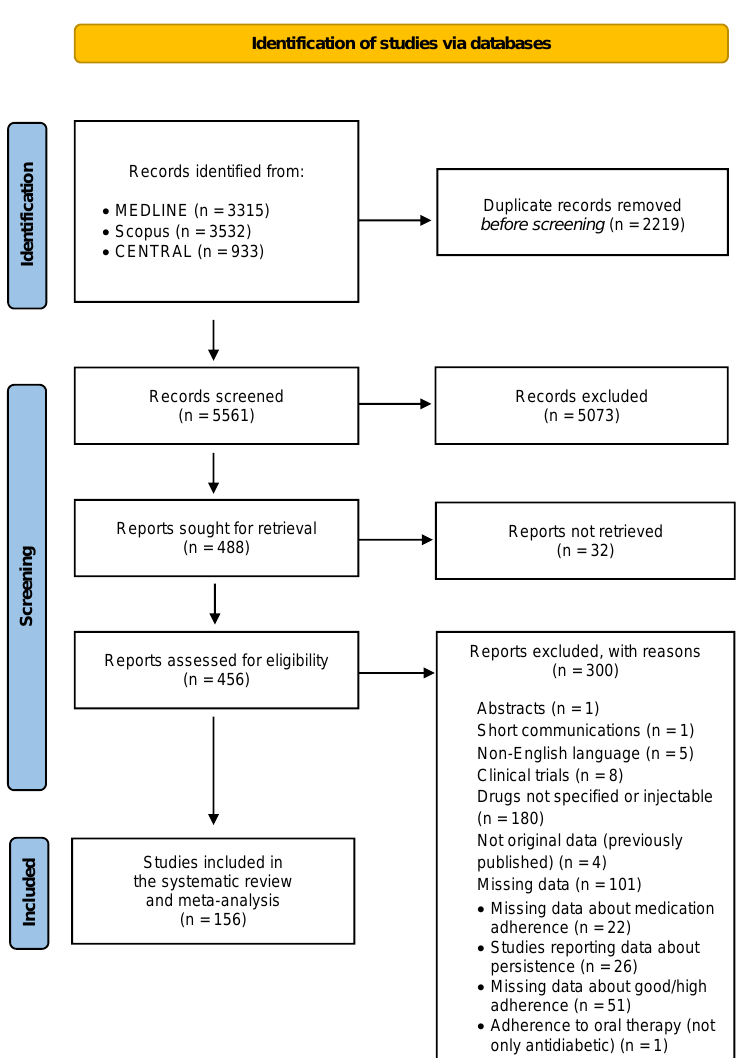
Figure 1. Flow chart of search.